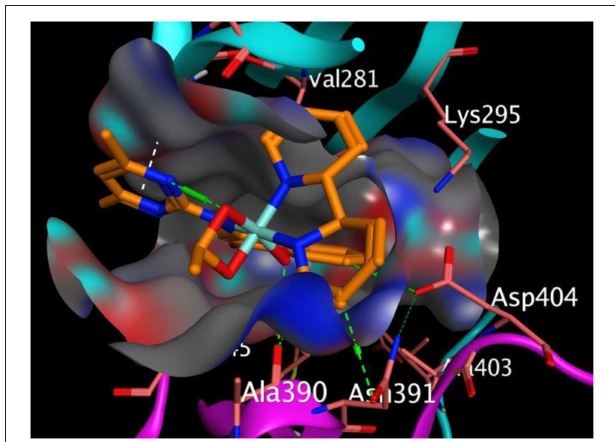
FIGURE 3 | Binding pose of compound 4 in the binding cavity of 2HCK (the green dotted lines signify H-bond; white dotted lines signify pi-H